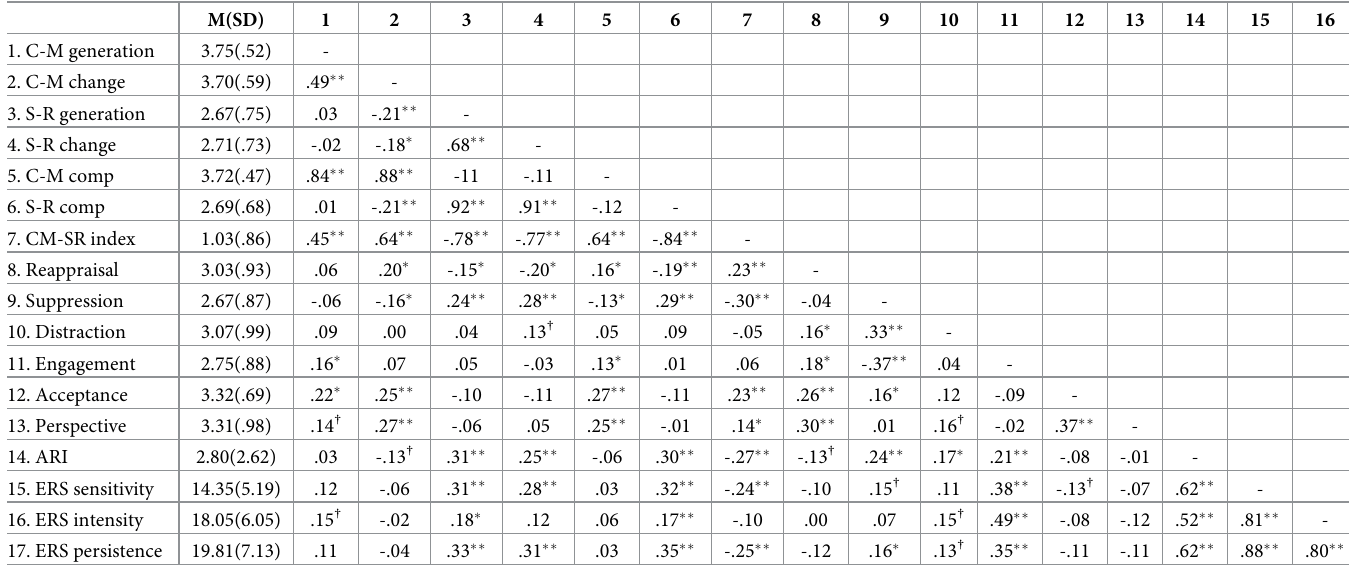
Table 5. Study 4 Pearson’s correlation coefficients (C-M comp = composite C-M score, S-R comp = composite S-R score, perspective = putting into perspective).